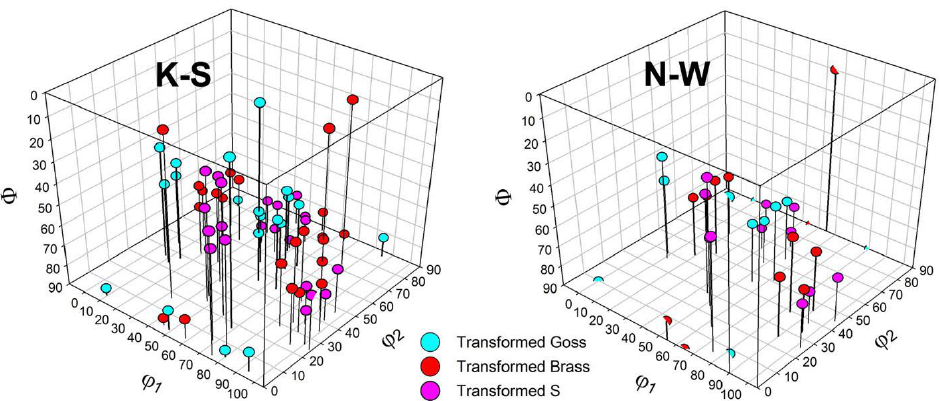
Figure 18. Orientations of martensite transformed from austenite with Brass, Goss, and S orientations through Kurdjumov – Sachs (K-S) or Nishiyama – Wassermann (N-W) orientation relationships.